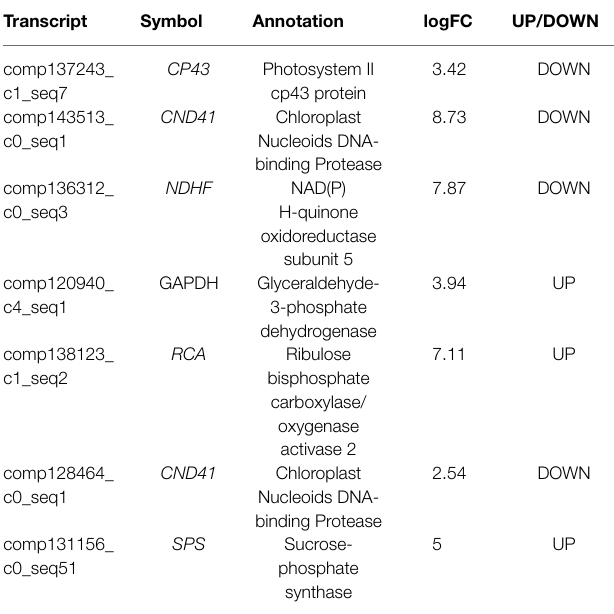
TABLE 1 | Expression of photosynthesis-related genes in white leaf comparing to green leaf.